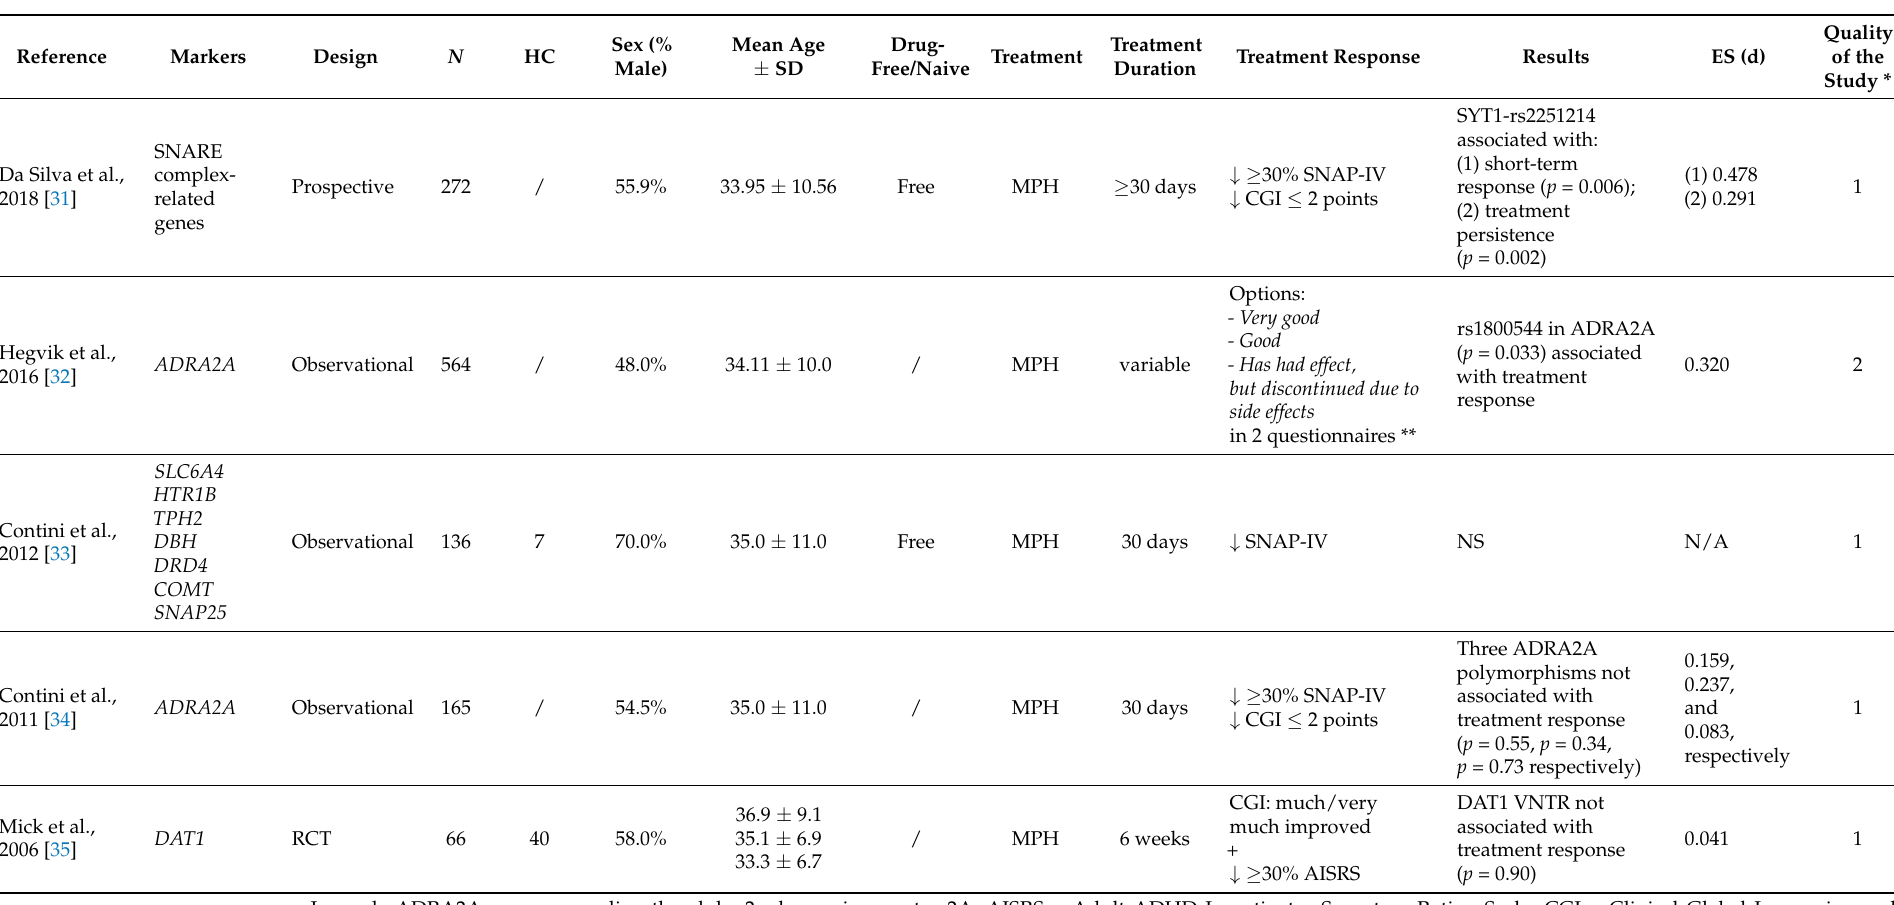
Table 1. Summary of the studies about genetic markers of treatment response in adult